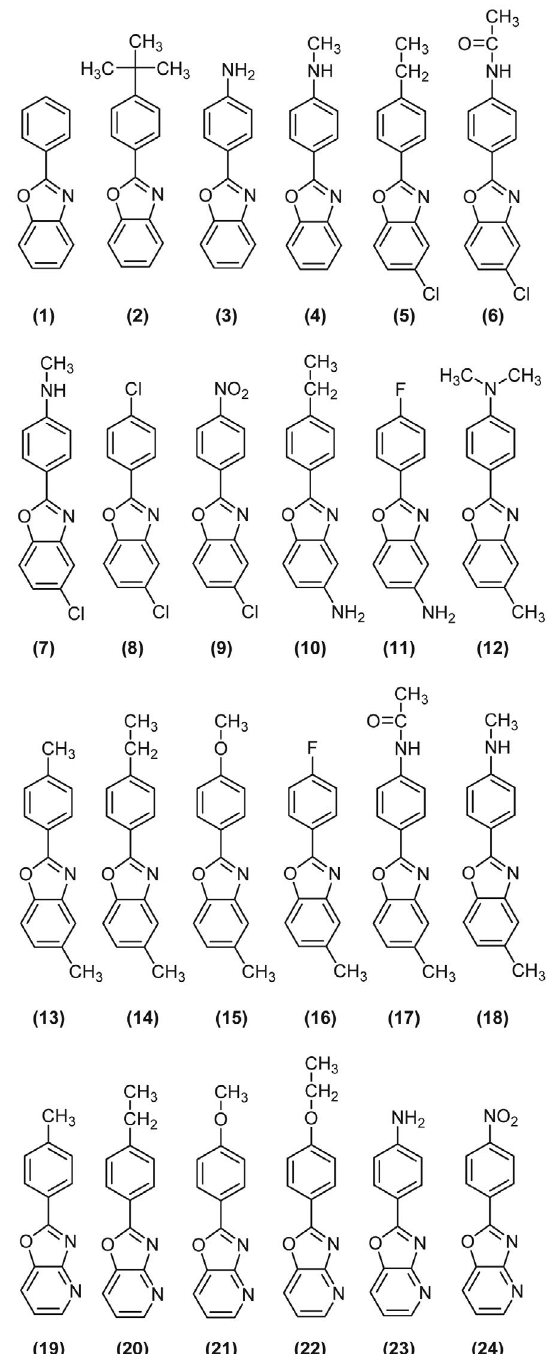
Figure 1. The molecular structures of the analyzed oxazole deriva-